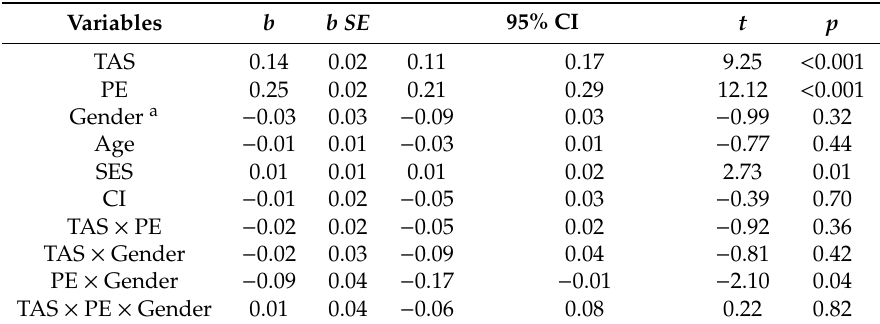
Table 2. Linear regression analysis predicting social competence from teacher autonomy support, perseverance, and students’